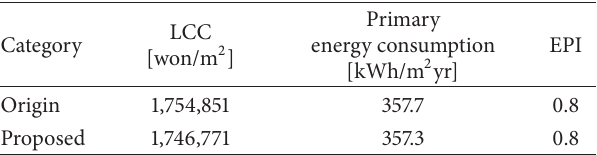
Table 8: Selected alternative when considering the LCC preferen- tially.